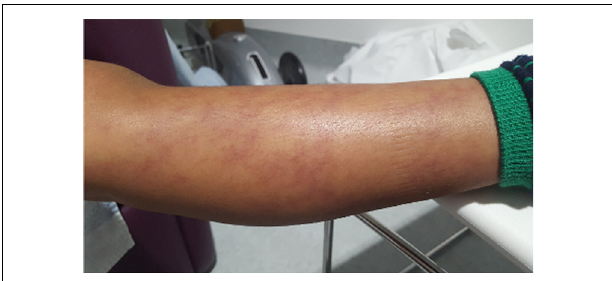
FIGURE 2 | Livedo racemosa type vasculitic skin rash in a DADA-2 patient. DADA-2, Deficiency of adenosine deaminase-2.